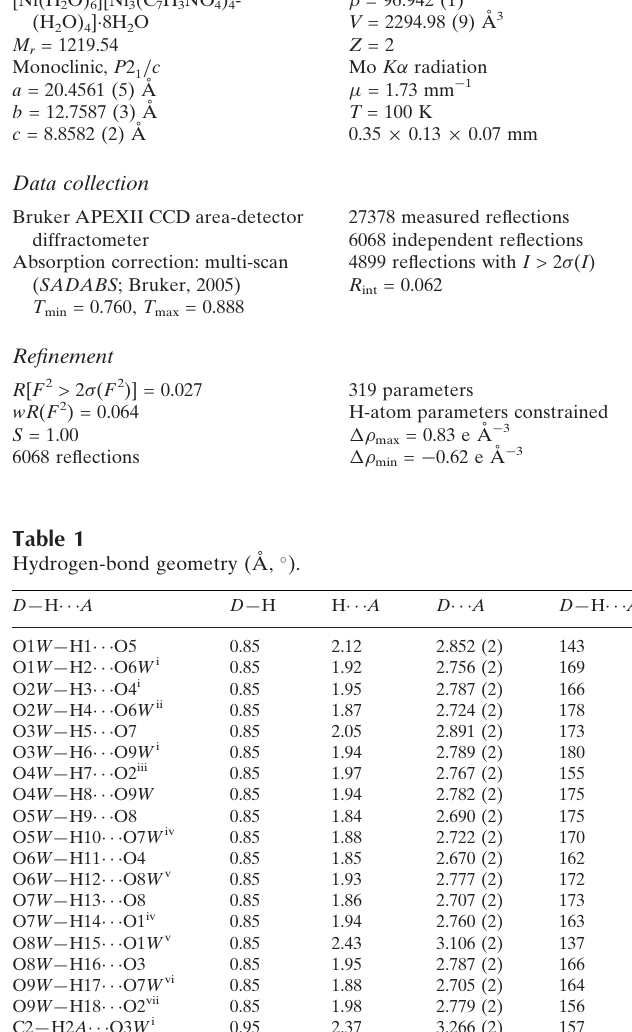
27378 measured reflections 6068 independent reflections 4899 reflections with I > 2 (cid:2) ( I ) R int = 0.062